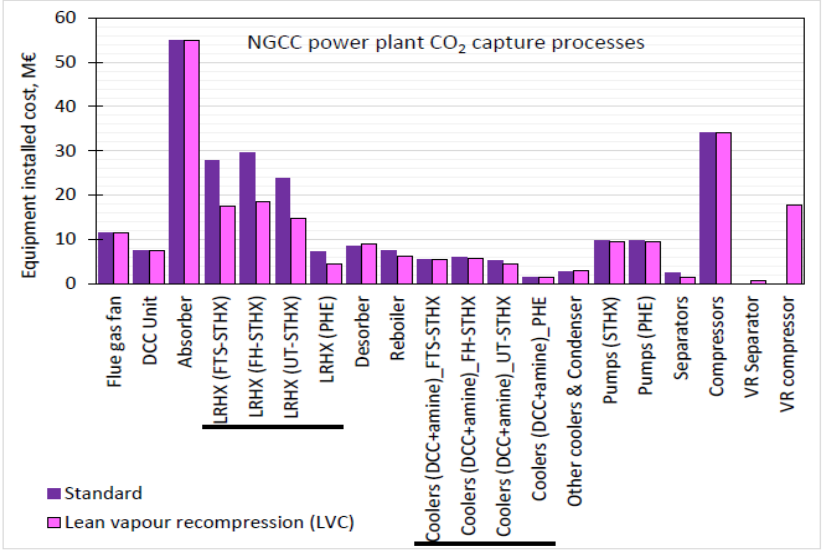
Figure 3. Capital cost distribution of 90% CO 2 standard capture plant and lean vapour compression plant for the 400 MW NGCC power plant’s exhaust gas.